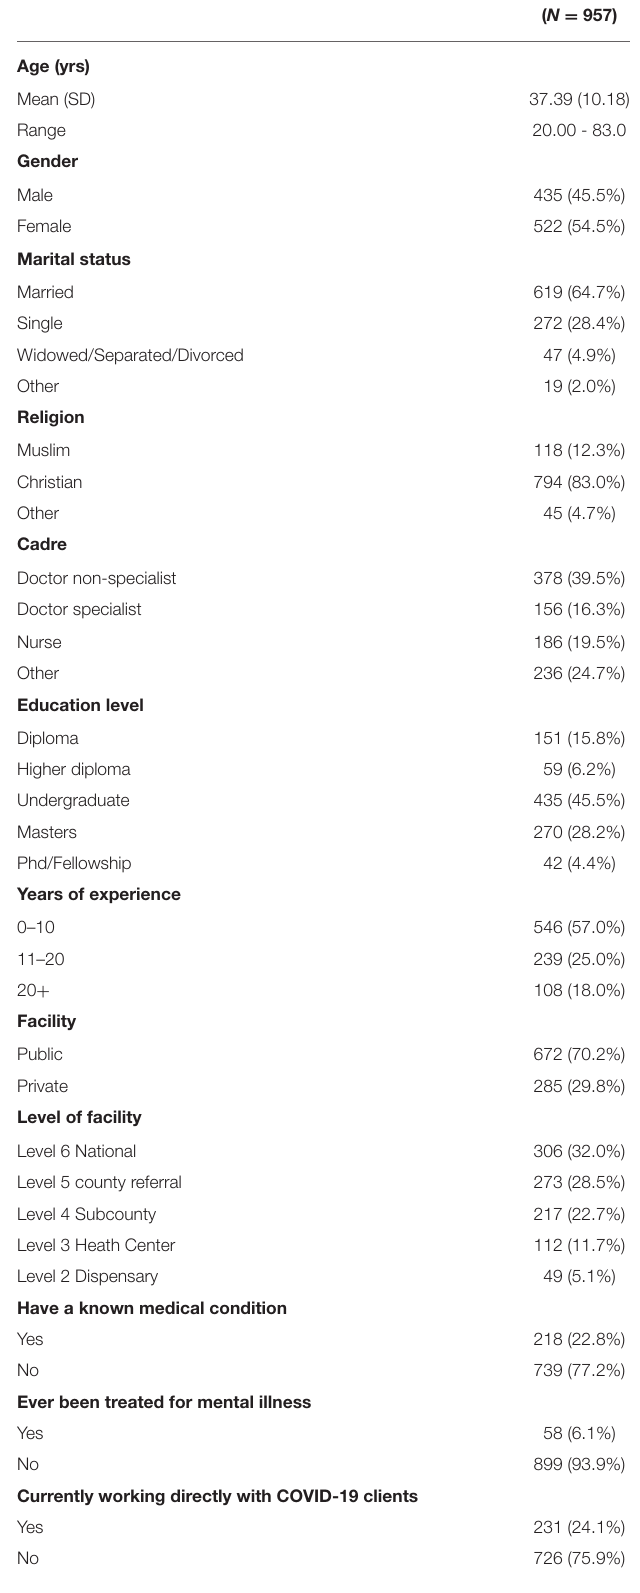
TABLE 1 | Sociodemographic characteristics of the